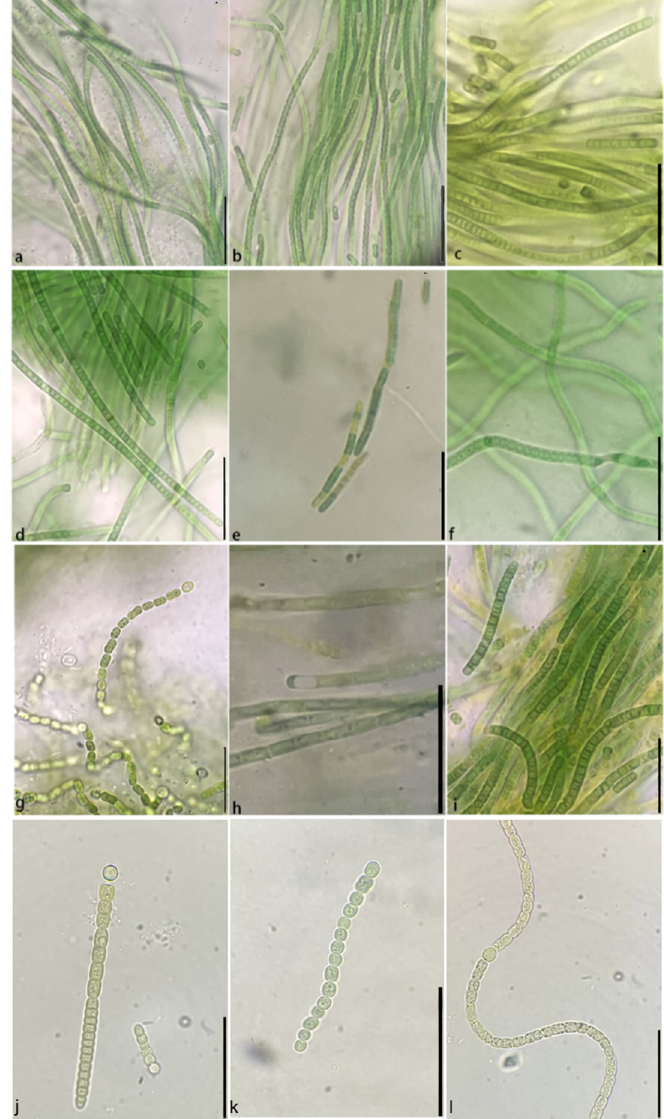
Figure 2. Cyanobacteria were observed in rice rhizosphere soil samples (Bars = 10 µ m). ( a ) Het- eroleibleibleinia (S6), ( b ) Leptolyngbya gelatinosa (S6), ( c ) Porphyrosiphon luteus (S5), ( d ) Porphyrosiphon ceylanicus (S5), ( e ) Leptolyngbya foveolara (S4), ( f ) Lyngbya circumcreta (S1), ( g ) Nostoc Kihlmani (S1), ( h ) Microchaete tenera (S3), ( i ) Phormidium irriguum (S2), ( j ) Oscillatoria amoena (S2), ( k ) Nostoc muscorum (S1), ( l ) Anabaena constricta